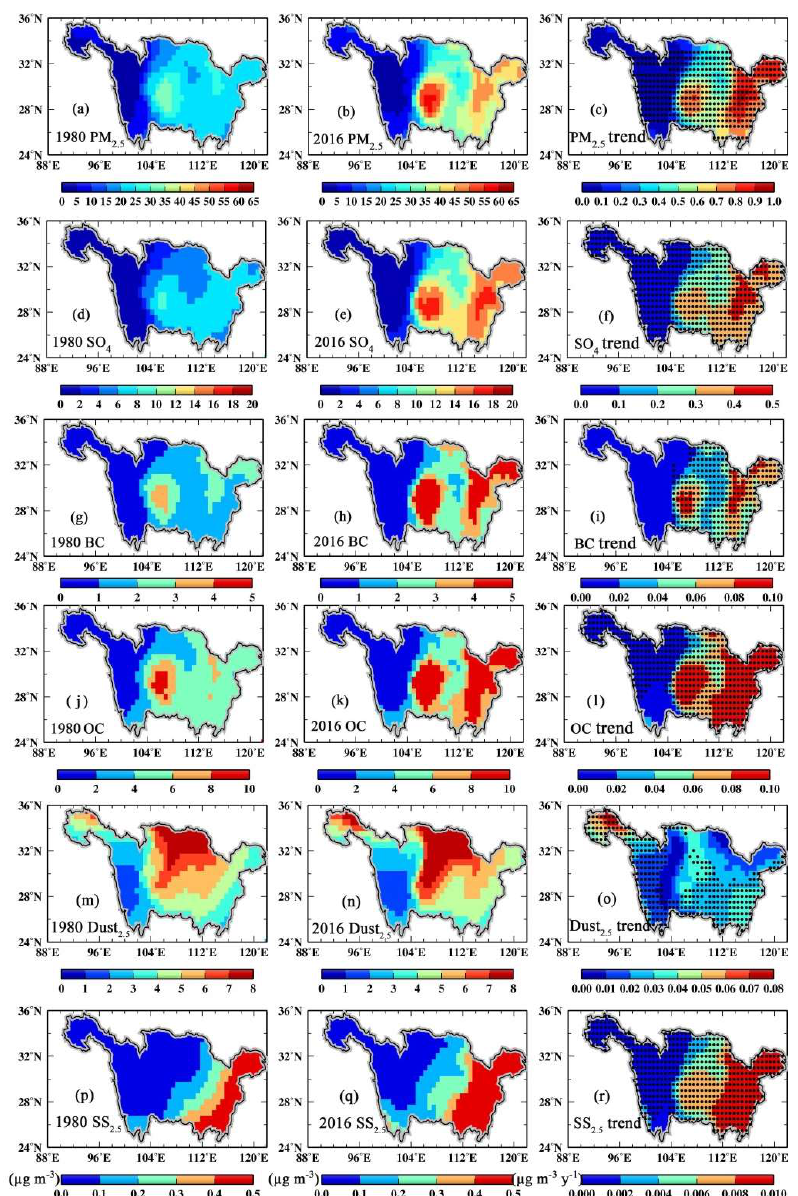
Figure 10. Spatial patterns of each MERRA-2 PM 2.5 component over the YRB from 1980 to 2017. The pixels marked with black dots represent significant trends (p < 0.05).